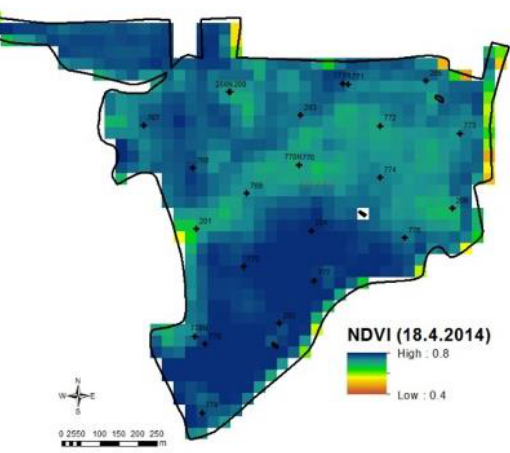
Figure 3. Landsat NDVI image of the experimental field